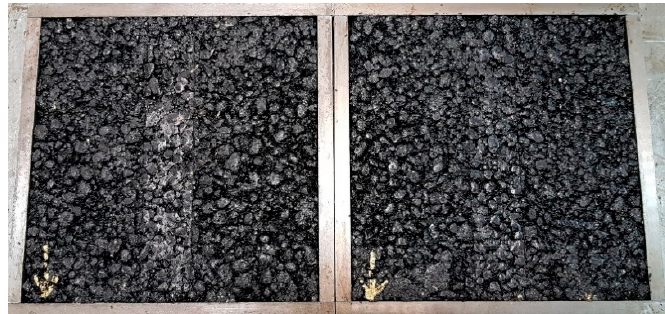
Figure 5. Specimens after wheel tracking test.